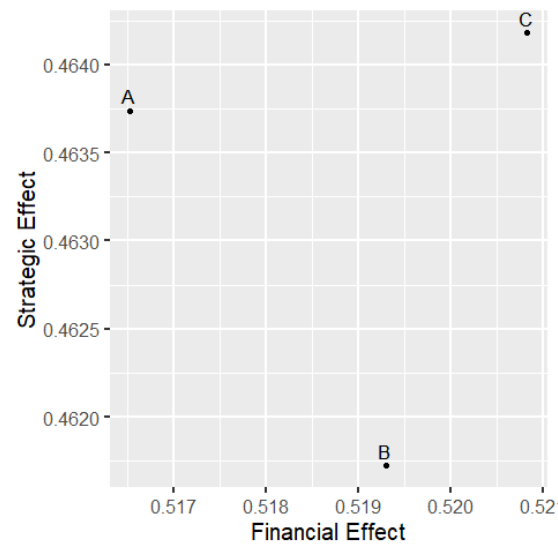
Figure 4. FCM (sigmoid threshold function): final states of Financial and Strategic Effects caused by Offers A, B, and